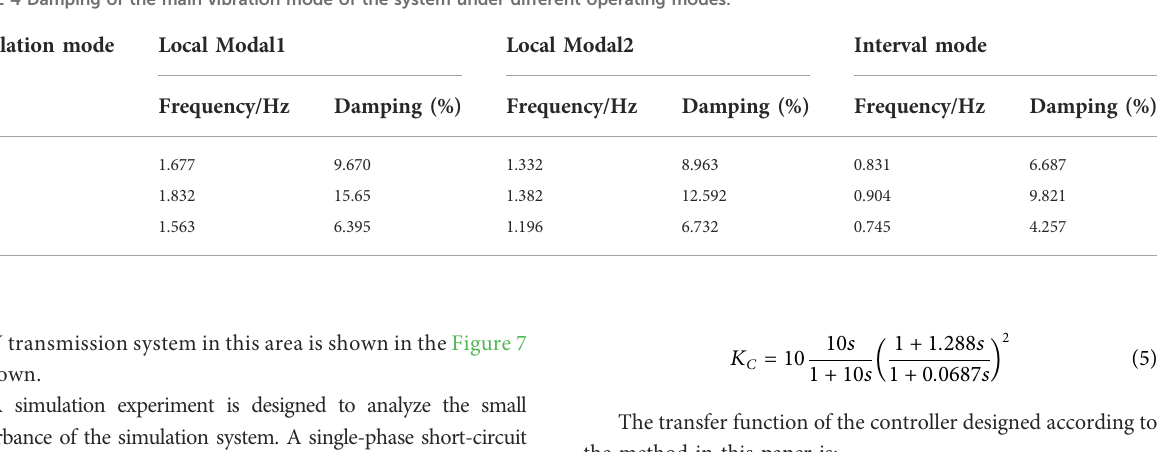
TABLE 4 Damping of the main vibration mode of the system under different operating